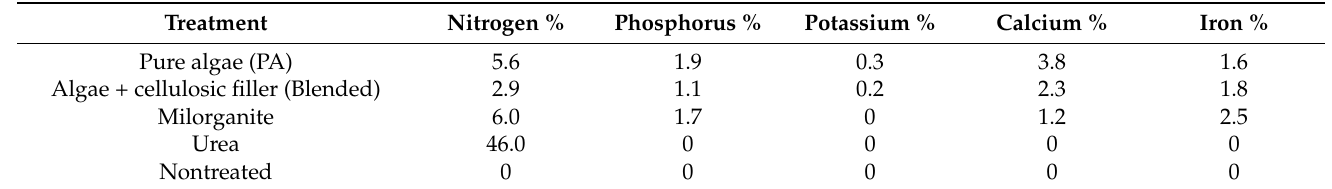
Table 1. Fertilizer treatments and nutrient